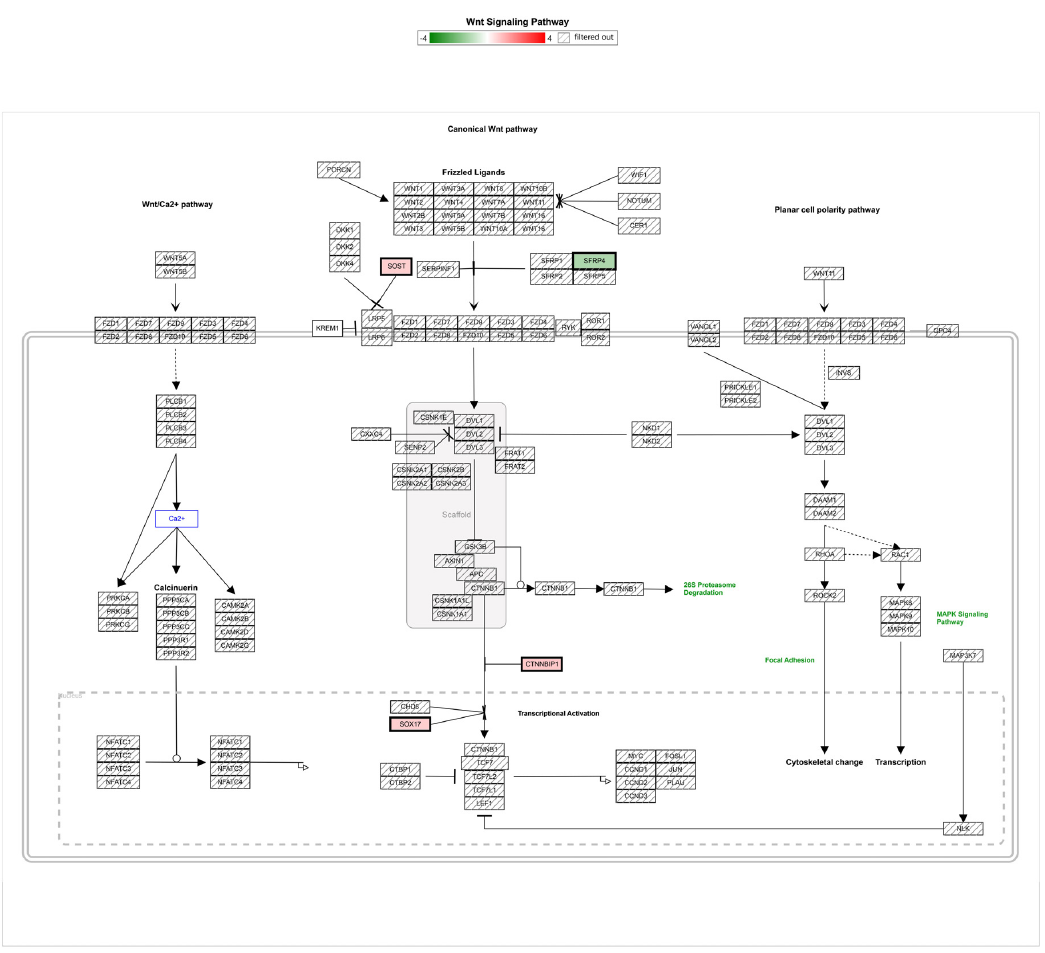
Figure 3. Illustration of the analyzed Wnt signaling genes in MG-63s on micro-pillars P5 compared with unstructured Ref. Note in particular the regulation of the Wnt / β -catenin pathway: P5 up-regulated genes (red-backed)—sclerostin ( SOST ), inhibitor of β -catenin and TCF-4 (ICAT), SRY-box transcription factor 17 ( SOX17 ); P5 down-regulated genes (green-backed)—secreted frizzled-related protein 4 ( SFRP4 ). In contrast, the non-canonical Wnt signaling pathways (Wnt / calcium and Wnt / planar cell polarity (PCP)) showed no di ff erence in mRNA (messenger ribonucleic acid) expression (filtered out). Illustration of the Wnt-WikiPathways. (TAC 4.0.2.1.5. software (Transcriptome Analysis